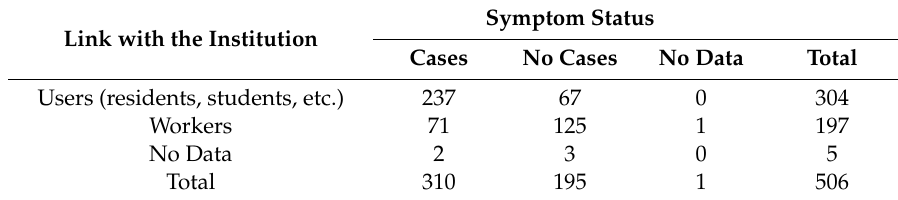
Table 2. Subjects included in the